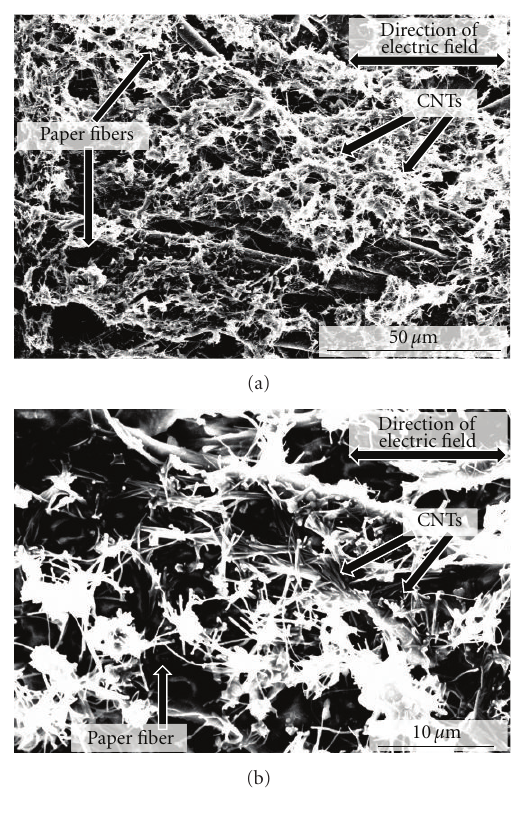
Figure 1: SEM image of CNT-composite paper ((a) low magnifica- tion, (b) high magnification). Dispersant was nonionic surfactant. CNTs were not aligned.